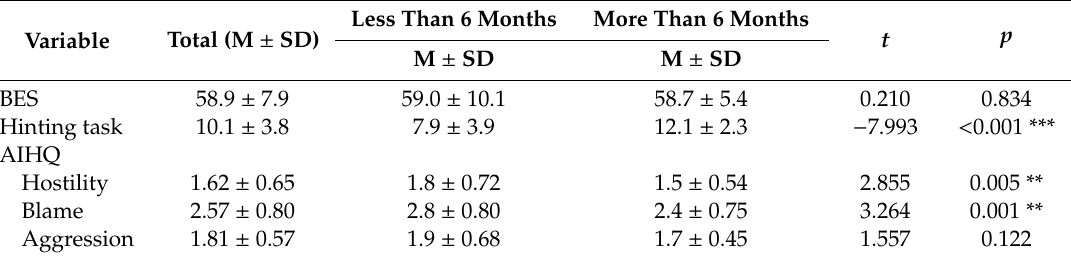
Table 4. Participants’ social